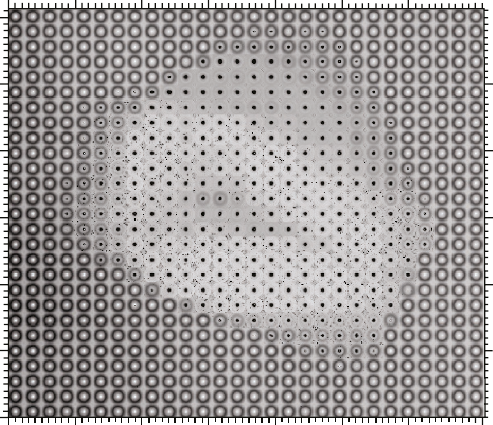
Figure 1: X-ray di ff raction patterns of the investigated bone sam-